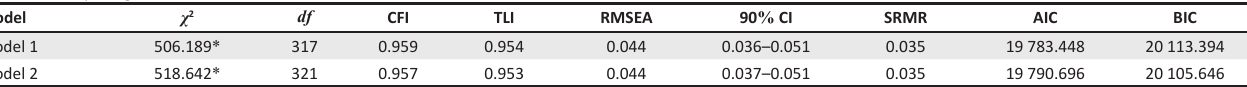
TABLE 2 : Competing measurement model fit statistics.